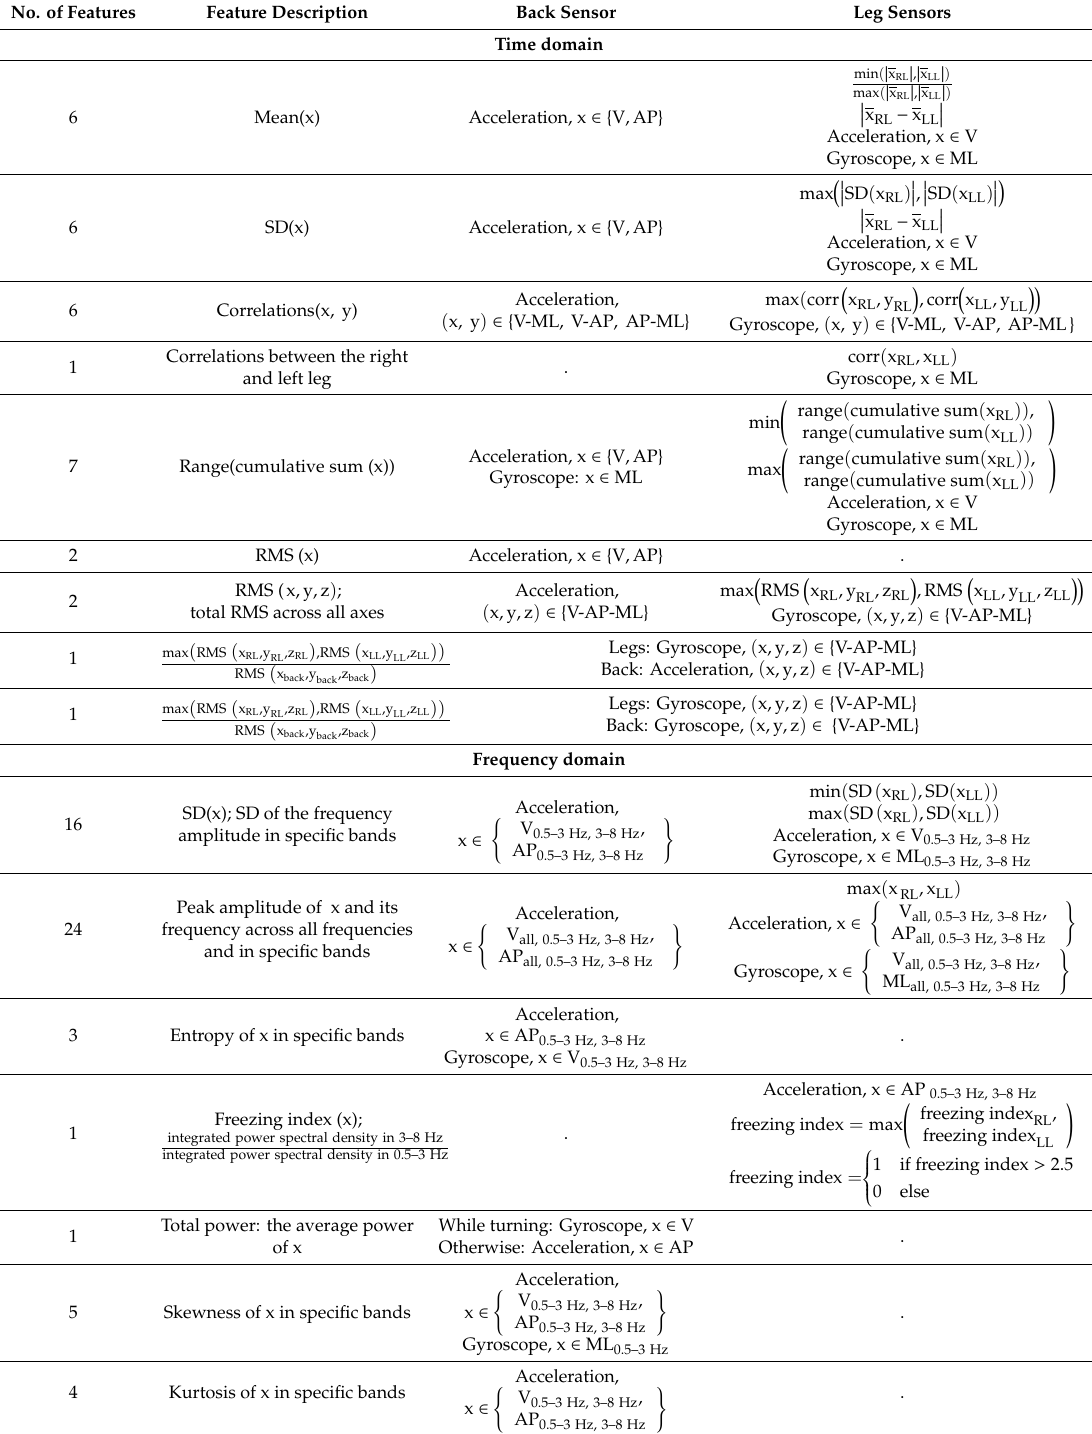
Table A1. The full feature set (84 features) that was used in the machine-learning